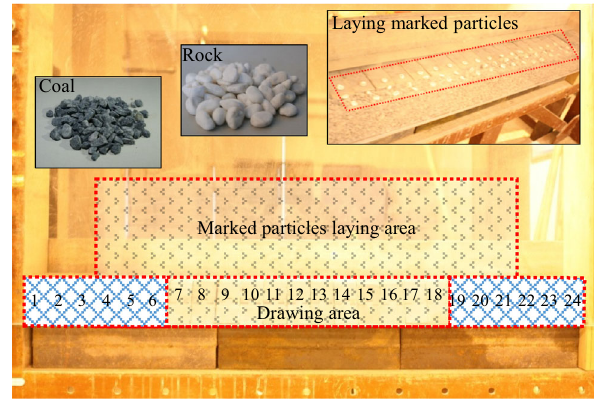
Fig. 1 Experimental device and layout of marker